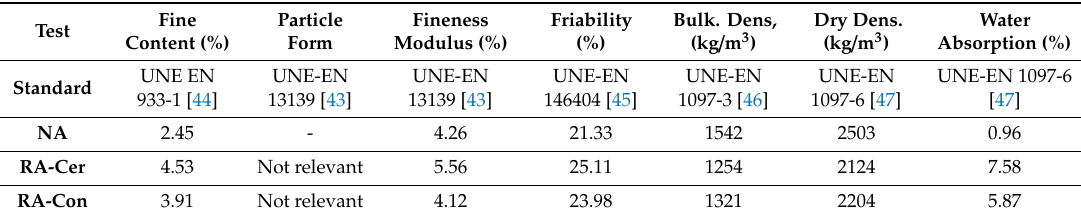
Table 3. Physical characterization of natural aggregate (NA), recycled arid ceramic (RA-Cer) and R-recycled concrete aggregate